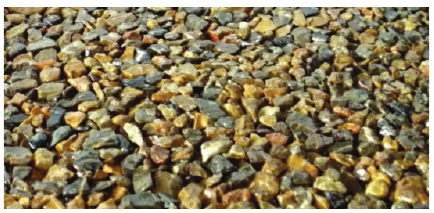
Figure 2: Composite geomembrane (CGM).